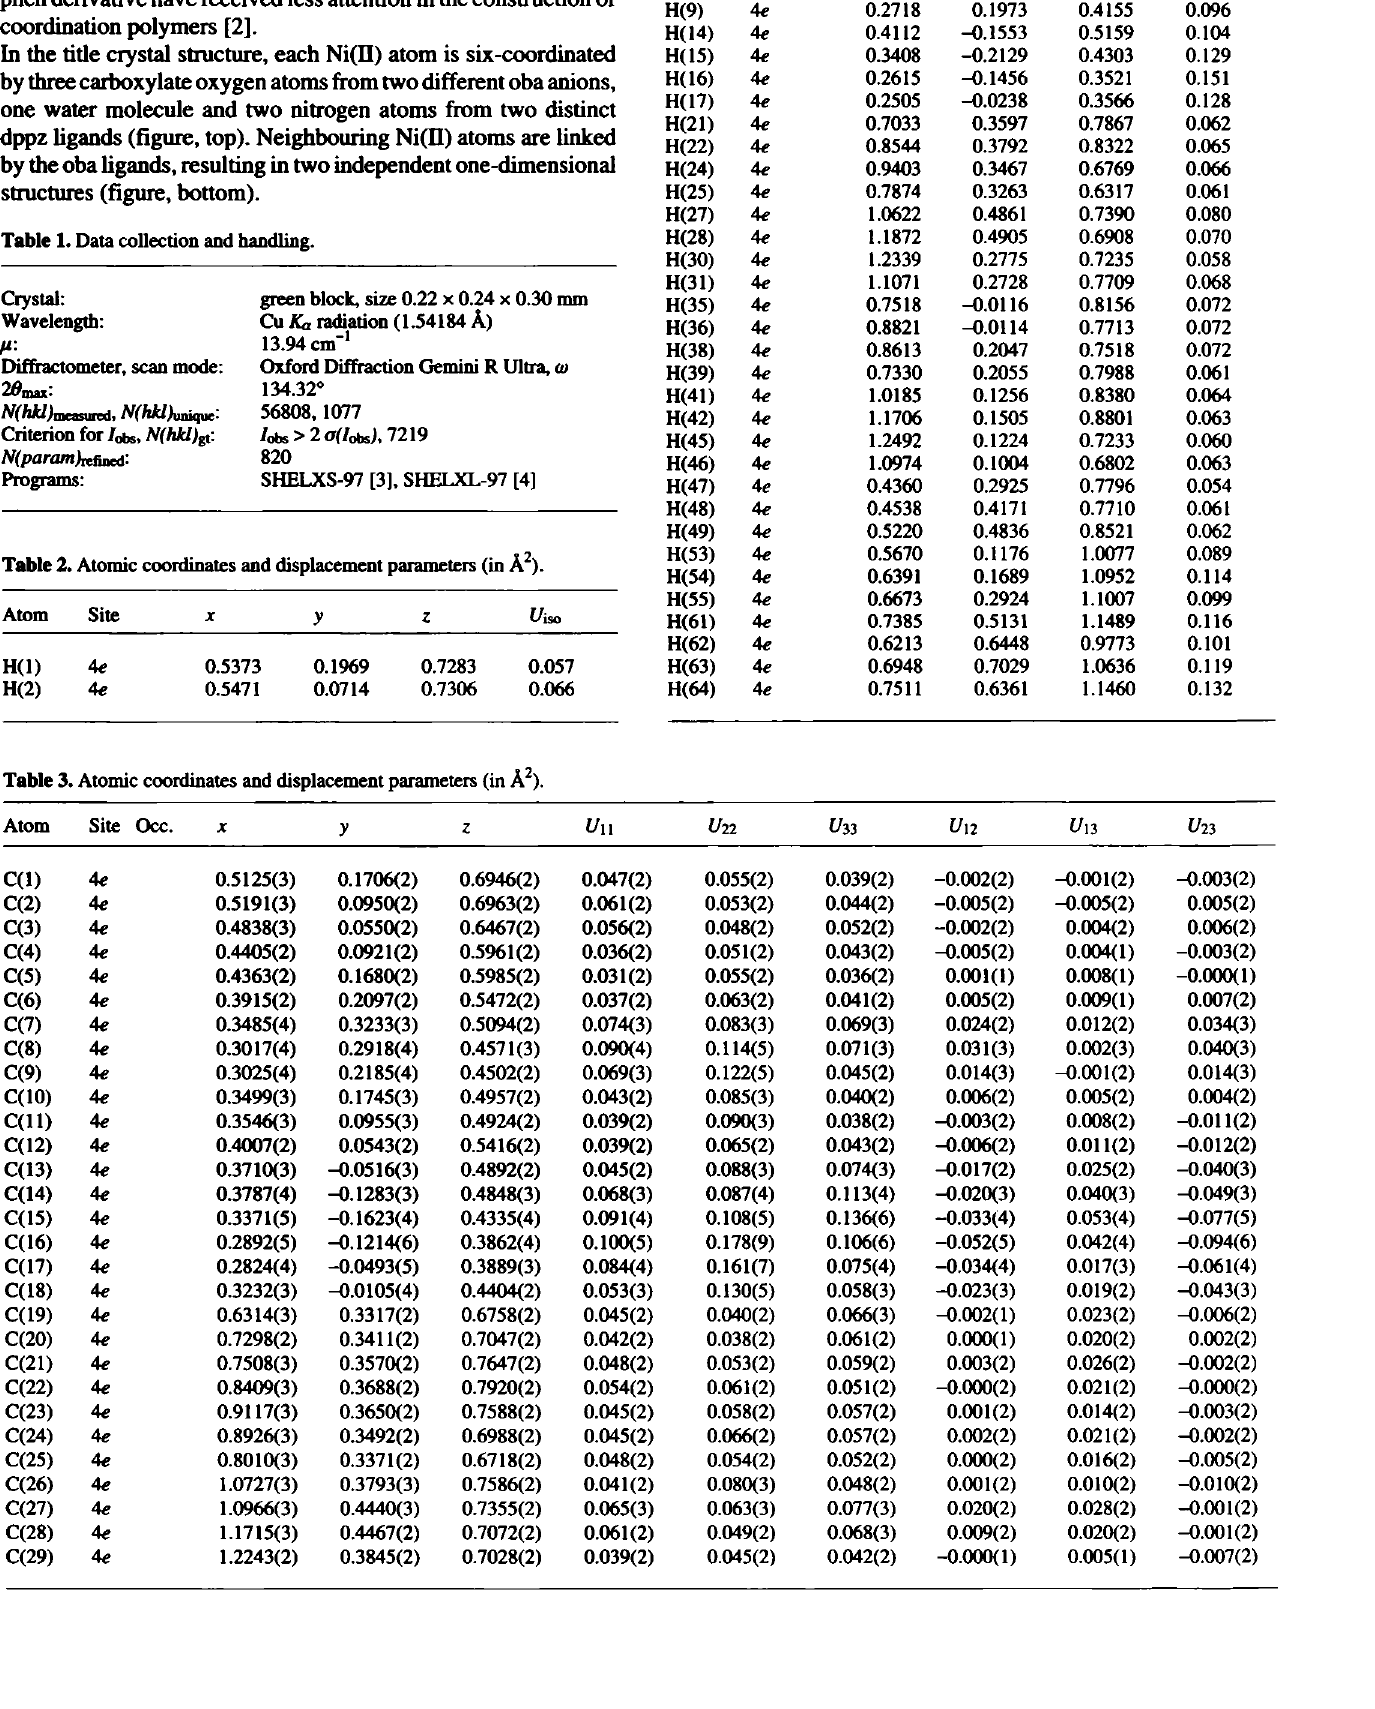
Table 2. Atomic coordinates and displacement parameters (in À 2 ).